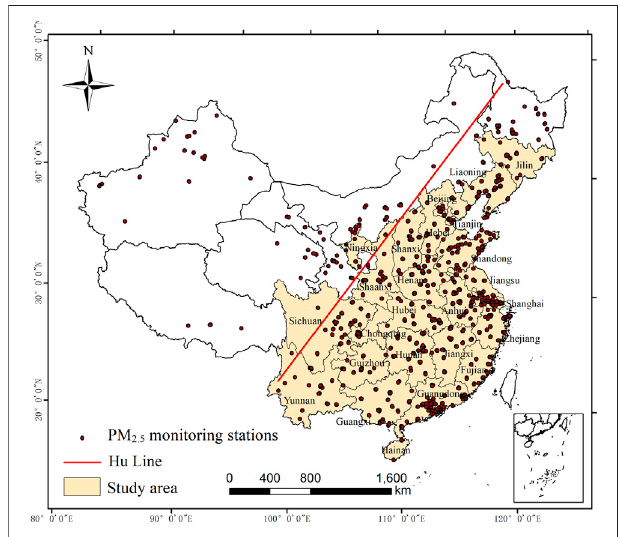
FIGURE 1 | Location of the study